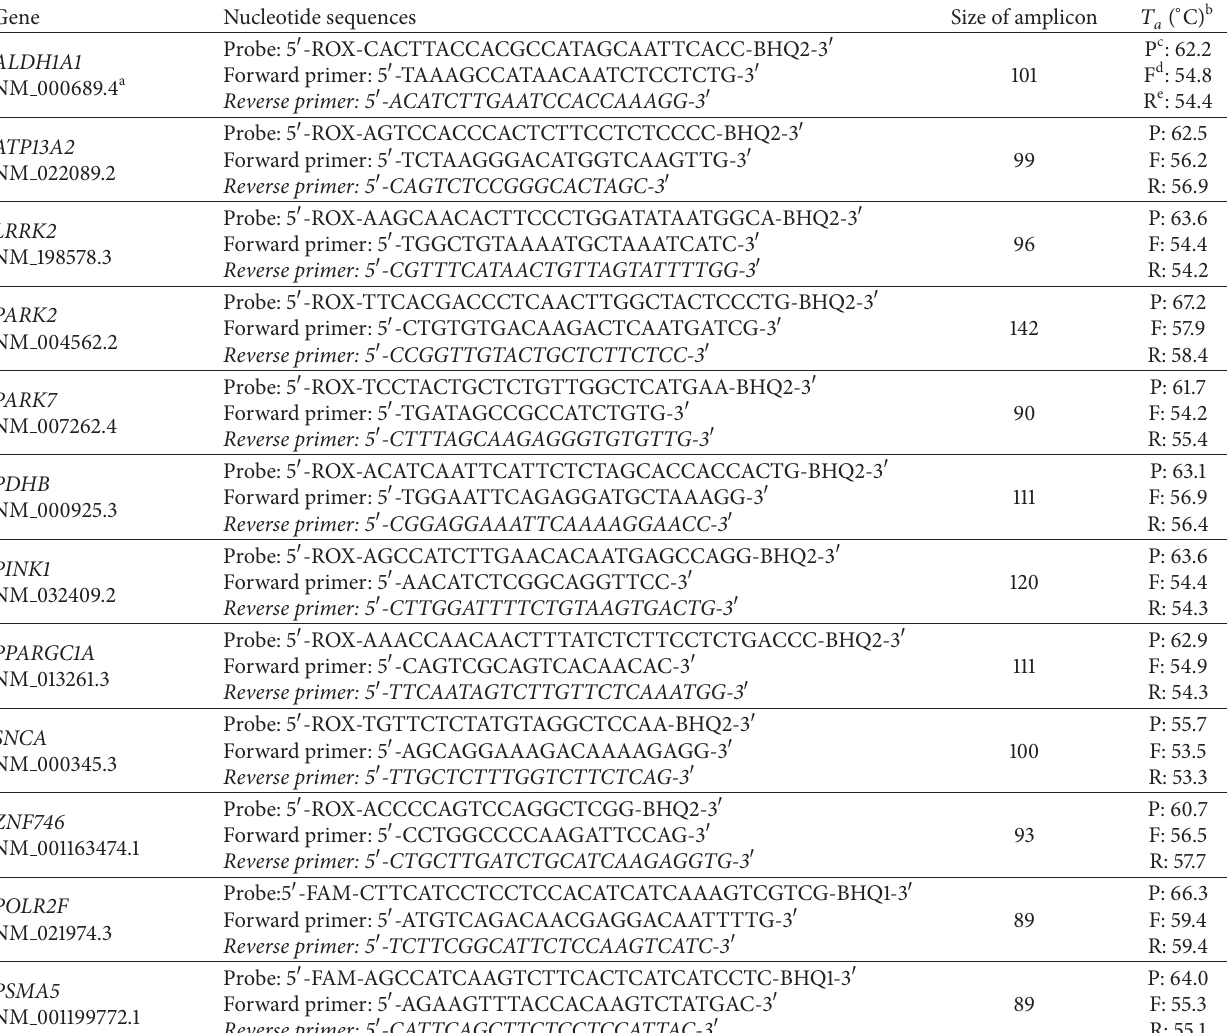
Table 1: Sequences of gene-specific primers and